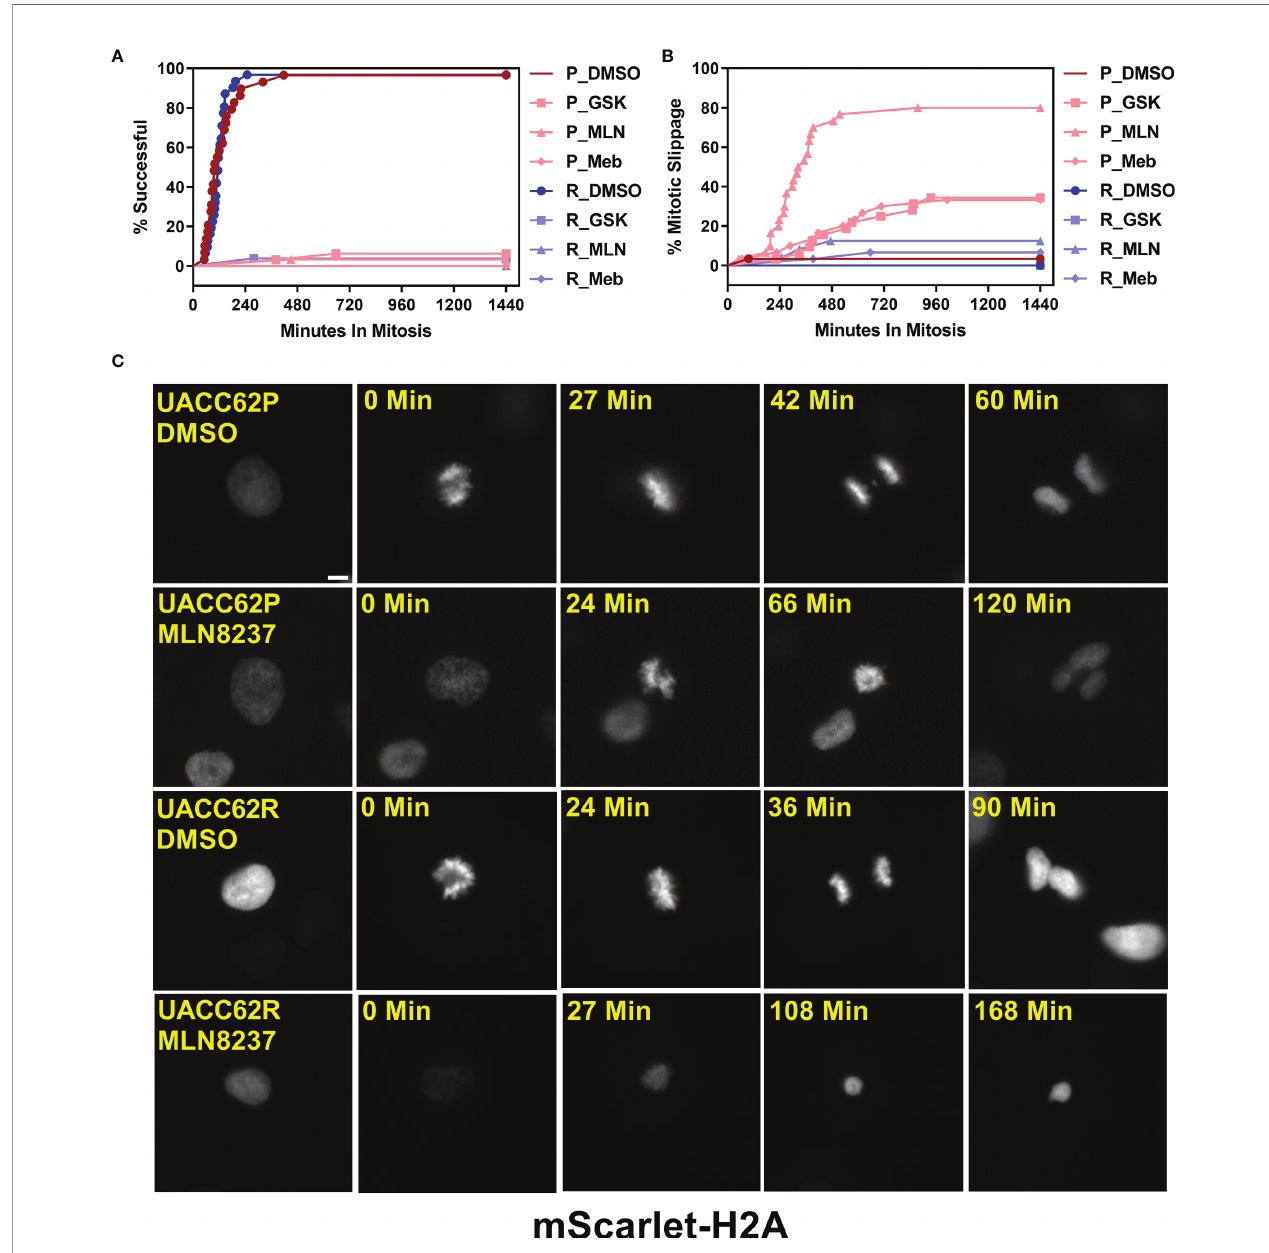
FIGURE 2 | Compound-treated UACC62P, but not UACC62R, cells undergo mitotic slippage. UACC62P/R cells were engineered to stably express GFP-TUBA1B and mScarlet-H2A. The cells were seeded into glass-bottom 96-well plates and the next day the cells were treated with 1 µM GSK461364, MLN8237, or Mebendazole. Mitotic timing and outcomes were analyzed as described in Materials and Methods . The fraction of cells which (A) successfully completed mitosis or (B) underwent mitotic slippage is plotted as a function of time. At least 40 cells were analyzed per treatment condition. (C) Representative images of DMSO or MLN8237-treated UACC62P/R cells. The relative timepoints represent the time between nuclear envelope breakdown and the terminal mitotic event (either successful mitosis, mitotic arrest, or aberrant mitosis). Images were captured using the DeltaVision microscopy setup as described in the Materials and Methods section. Scale bar = 10